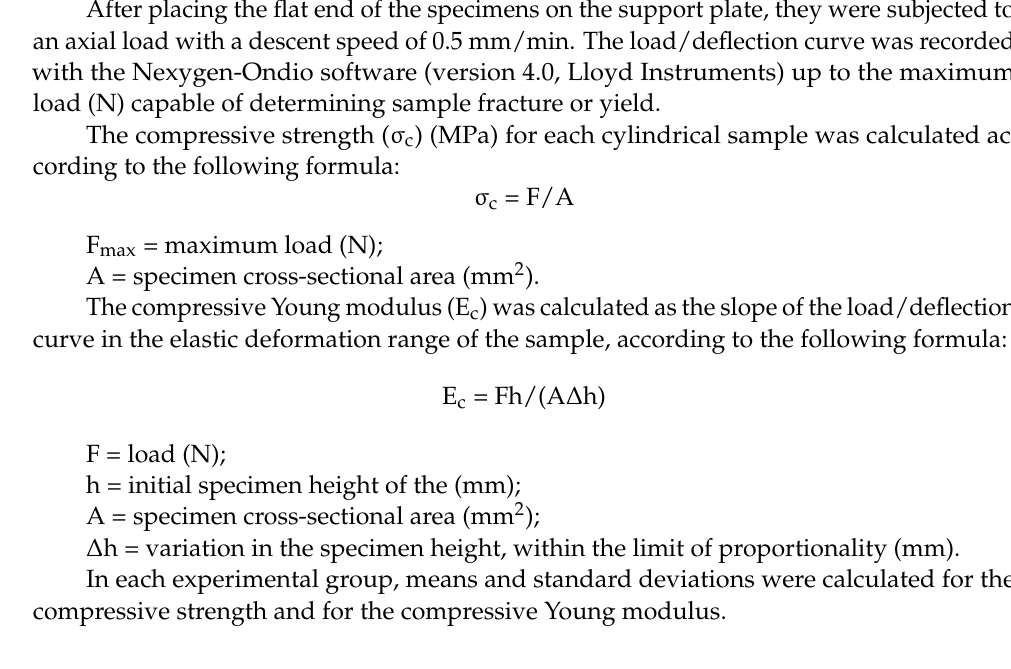
Figure 4. G-PMMA specimen ready to be subjected to compressive load in a universal testing machine.